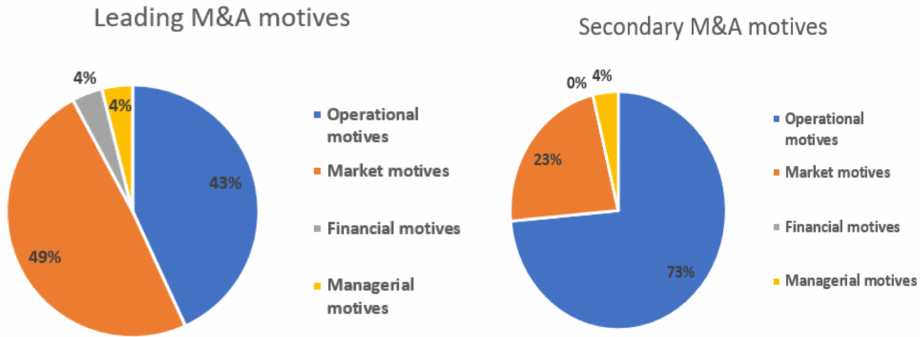
Figure 4. The frequency of occurrence of the leading and secondary M&A motives in the transactions conducted by the public companies from the electrical energy generation sector during the period 1 January 2015–19 November 2021 in the research sample, grouped by the motive